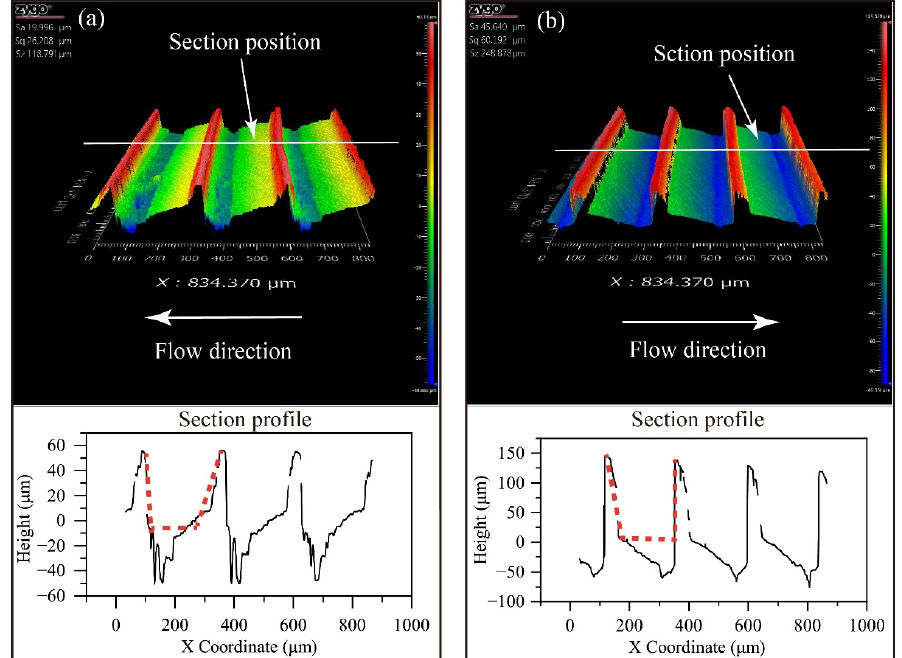
Figure 1. Microscopic morphology of pigeon feathers: ( a ) the topography and section profile of feather head; ( b ) the topography and section profile of feather root; the black lines on the section profile are the real shape of feathers and the red dotted lines are the simplified shape of the structures.